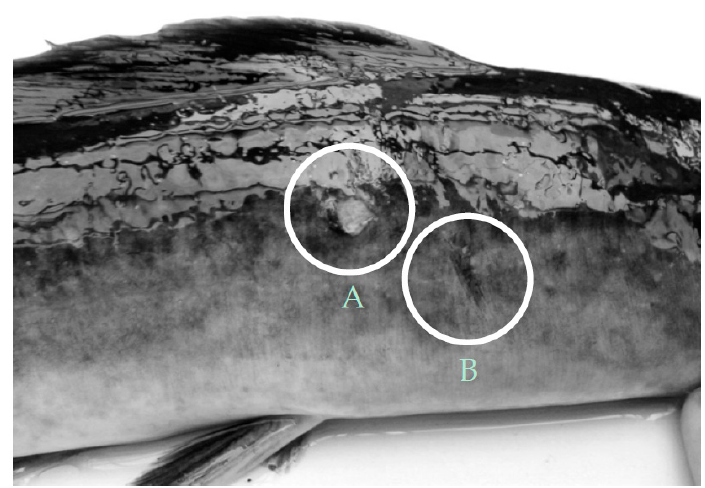
Figure 2. Heteromorphic skin injuries of C. gariepinus ; A: penetrating wound reaching down to the underlying tissue; B: non-penetrating wound (abrasion). Photo processed with amplified contrast (+20%).